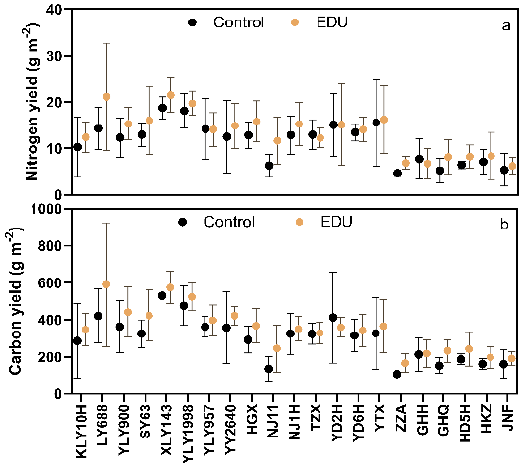
Figure 5. Nitrogen ( a ) and carbon ( b ) yield in the control and ethylenediurea (EDU) plots, among 21 rice cultivars. The mean (circle) and 95% confidence interval (short horizontal lines connected with a vertical line) are shown for comparison between EDU and control treatments.